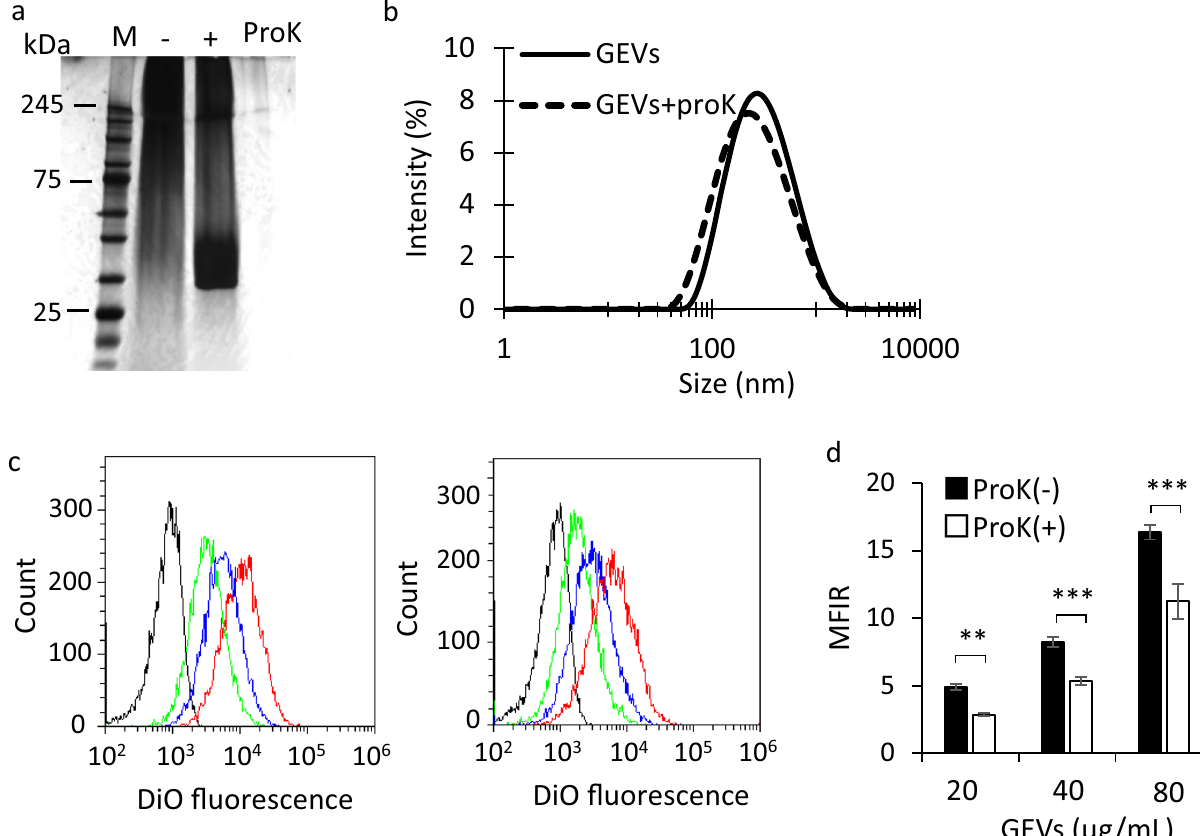
Figure 7. Effect of protein on cellular uptake of GEVs. ( a ) Sodium dodecyl sulfate–polyacrylamide gel electrophoresis (SDS-PAGE) of proteinase K (ProK)-treated and untreated GEV proteins. The lane of M represent molecular weight marker. Original gels are presented in Supplementary Fig. 3. ( b ) Size distribution of untreated GEVs (solid line) and ProK-treated GEVs (dotted line) by dynamic light scattering (DLS). ( c ) Representative histogram of results obtained using flow cytometry (FACS). HaCaT cells were treated with 20 (green line), 40 (blue line), or 80 µg/mL (red line) 3,3 ′ -dioctadecyloxacarbocyanine perchlorate (DiO)-labeled GEVs (left) or PBS (black line) for 3 h. ( d ) The mean fluorescence intensity ratios (MFIR) obtained for the HaCaT cells treated with DiO-labeled GEVs. Data are presented as the mean ± S.D. **p < 0.01, ***p < 0.001 (n =